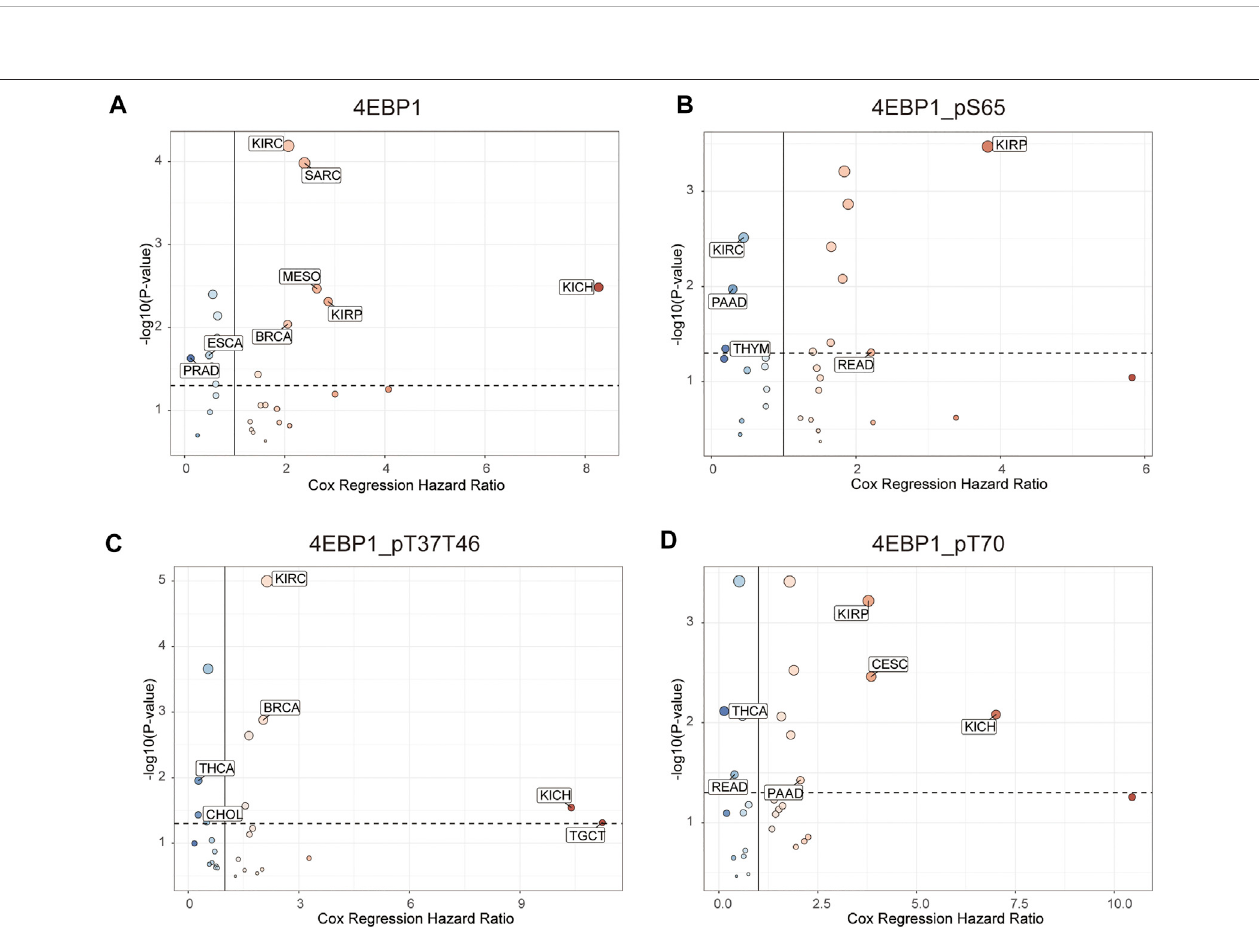
FIGURE 4 | The prognostic signi fi cance of 4EBP1 protein, 4EBP1_pS65, 4EBP1_pT37T46, and 4EBP1_pT70 phosphoproteins in Pan-cancer. The survival hazard ratios of (A) 4EBP1 protein, (B) 4EBP1_pS65, (C) 4EBP1_pT37T46, (D) 4EBP1_pT70 across all 33 cancer types were assessed using the Cox regression model. The cancer types in which the target protein plays as a poor prognostic factor (HR > 2, p < 0.05) were exhibited with pink dots. The cancer types in which the target protein plays as a favorable prognostic factor (HR < 0.5, p < 0.05) were displayed with blue dots.